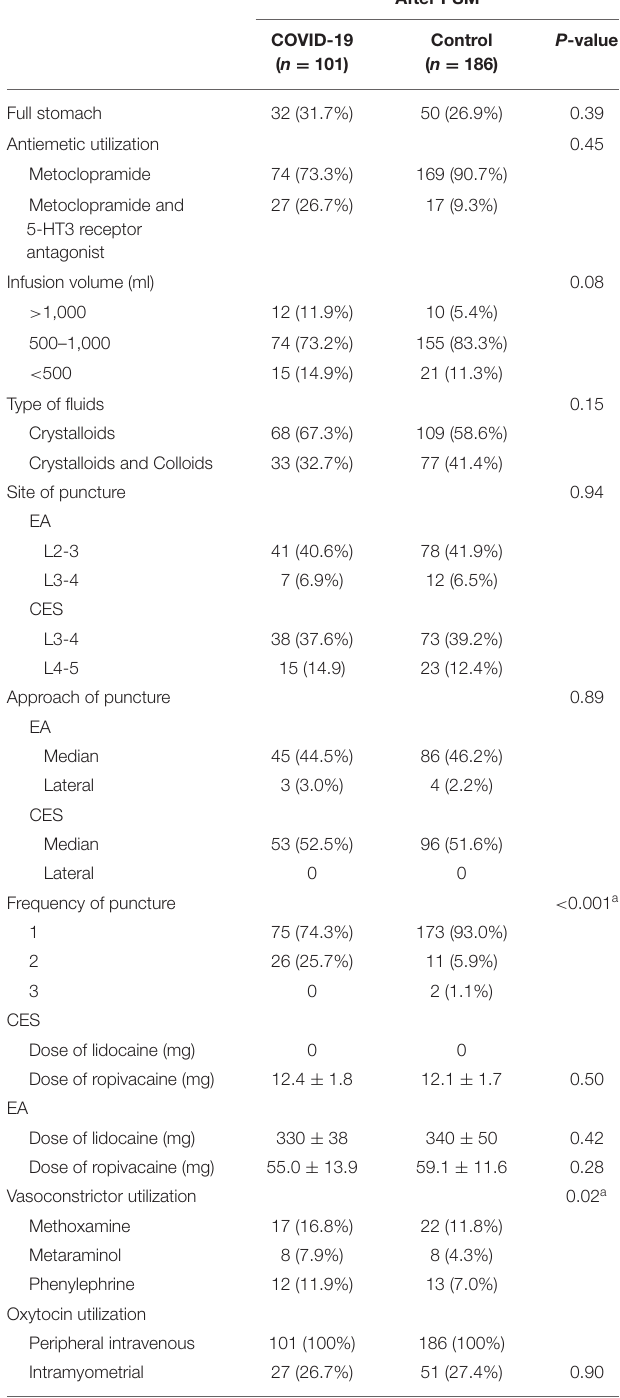
TABLE 2 | The incidences of neuraxial anesthesia-related hypotension in COVID-19 group vs. Control group before and after propensity score matching (PSM).